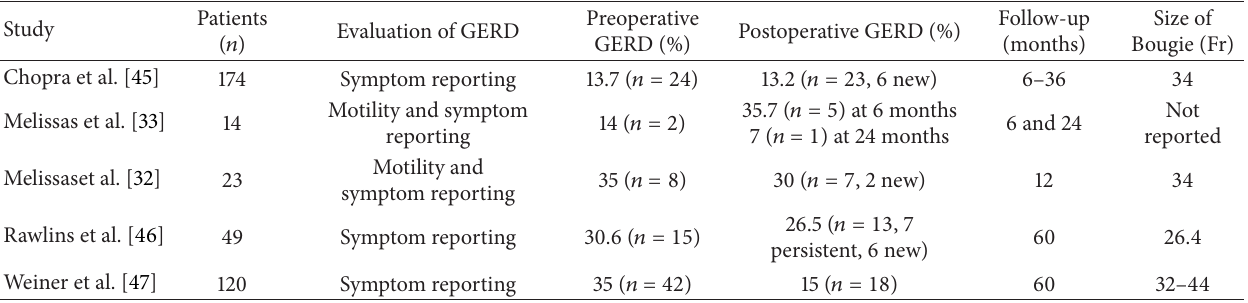
Table 2: Summary of studies showing reduced GERD after sleeve